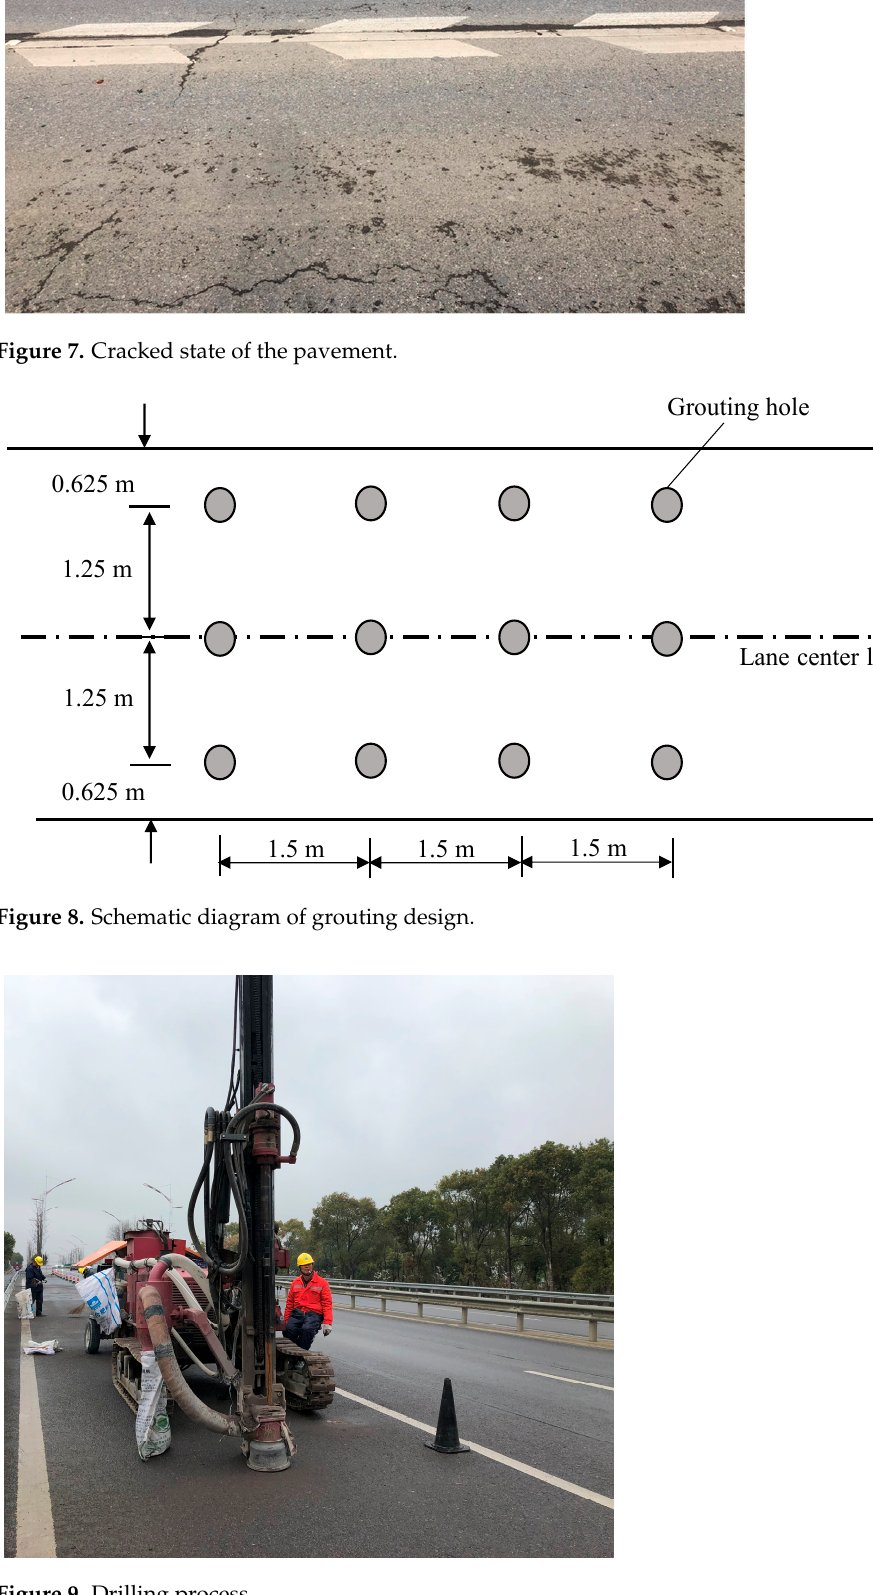
Figure 9. Drilling process. Figure 9. Drilling